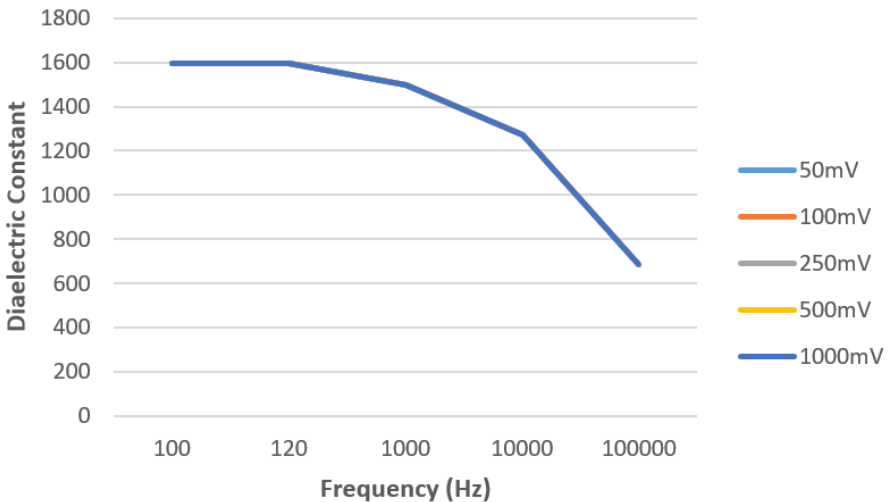
Figure 7. Dielectric constant as a function of frequency at different bias for Fe ‐ ZnSe crystal. Data were identical for all biases applied to the crystal.